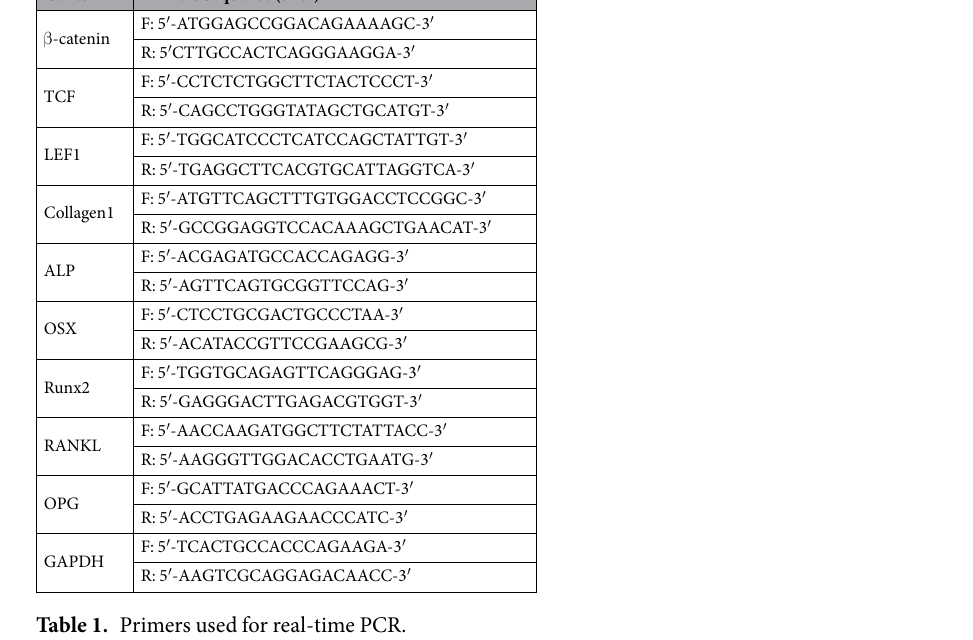
Table 1. Primers used for real-time